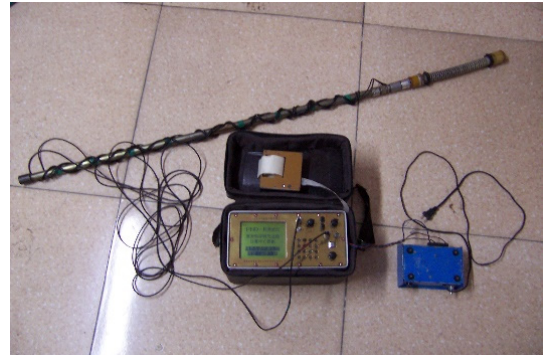
Figure 5. Phd-2 multifunctional ultrasonic detector.